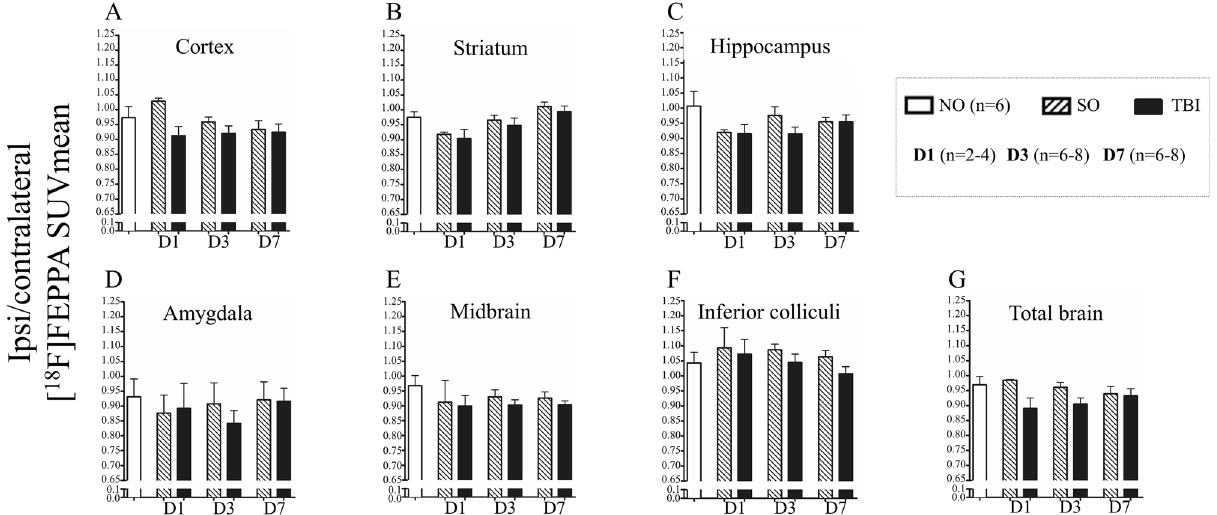
Figure 1. PET ipsi/contralateral [ 18 F]FEPPA SUVmean for NO, SO, and TBI mice at D1, D3 and D7. In ( A ) cortex, ( B ) striatum, ( C ) hippocampus, ( D ) amygdala, ( E ), midbrain, ( F ) inferior colliculi and ( G ) the sum of the 6 regions. Data are expressed as means ± S.E.M. Differences were analyzed using a one-way ANOVA. D Day, NO Non Operated, SO Sham-operated, SUV standard uptake value, TBI traumatic brain injury.